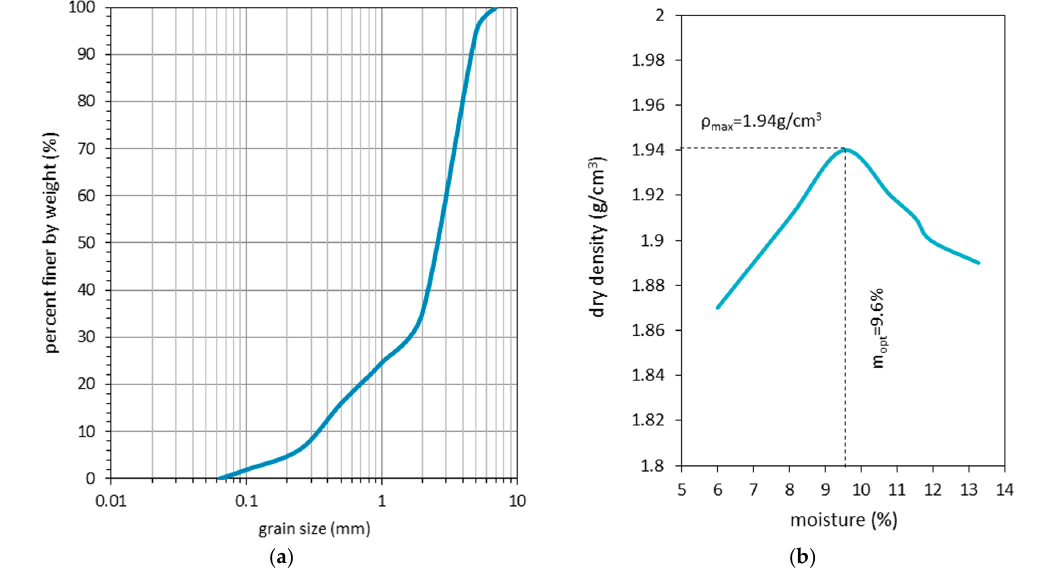
Figure 2. Results for the ( a ) soil gradation curve and ( b ) Proctor test for the experimented RCA.